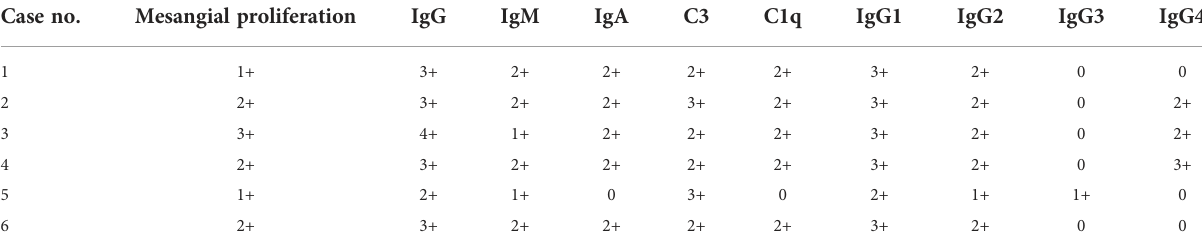
TABLE 4 Pathological and immuno fl uorescent features of lung cancer patients with nephropathy as the fi rst manifestation. Case no.